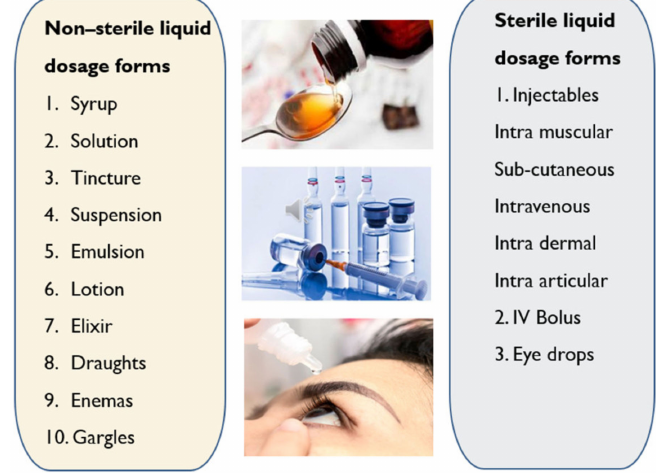
Figure 9. Sterile and non-sterile liquid dosage